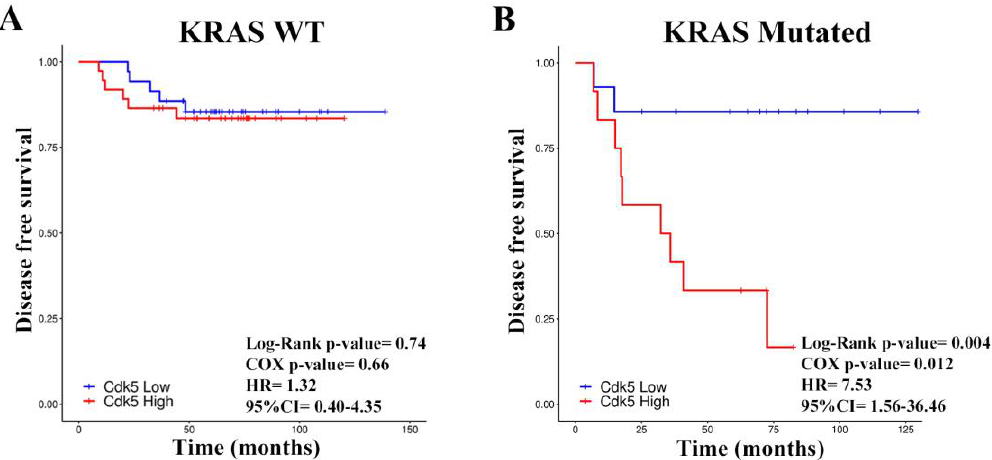
Figure 5. Kaplan–Meyer analysis of disease free survival (DFS) depending on Cyclin dependent kinase (Cdk5) expression and Kirsten rat sarcoma oncogene ( KRAS) mutational status. ( A ) DFS for 72 stage II colorectal cancer (CRC) patients with wildtype (WT) KRAS and split by the median of Cdk5 expression. ( B ) DFS for 26 stage II CRC patients with mutated KRAS and split by the median of Cdk5 expression (cohort B).